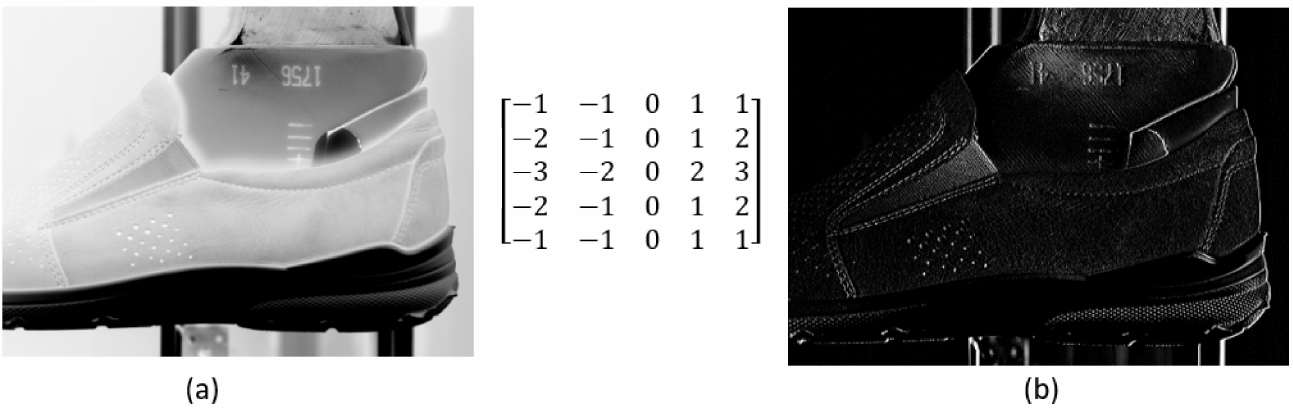
Figure 5. Original ( a ) and filtered ( b )